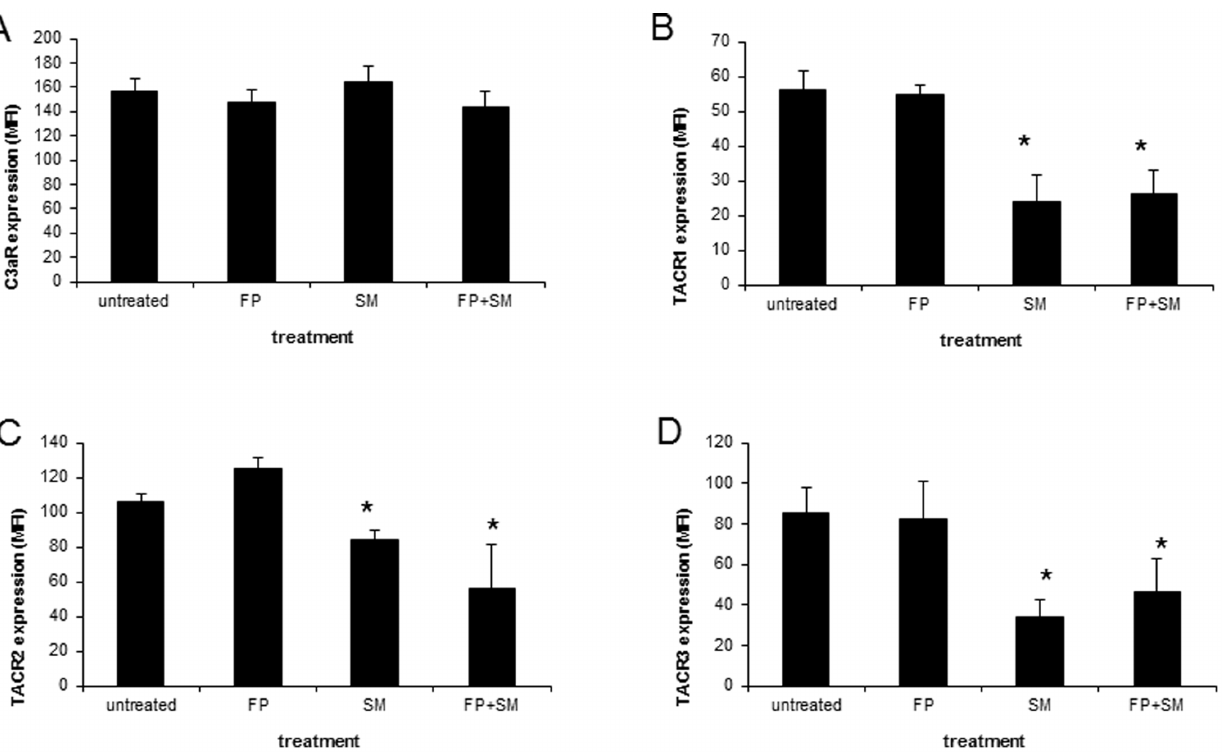
Figure 8. Salmeterol inhibits neurokinin receptor expression. LAD2 human mast cells were treated with fluticasone (1 uM) or salmeterol (1 uM) or combination for 20 hr, and C3aR ( A ), neurokinin receptor 1(TARC1; B ), 2 (TARC2; C ) and 3 (TARC3; D ) expression was measured by flow cytometry. Data are expressed as mean fluorescence intensity (MFI; n=5, *=p , 0.05 compared to untreated control).